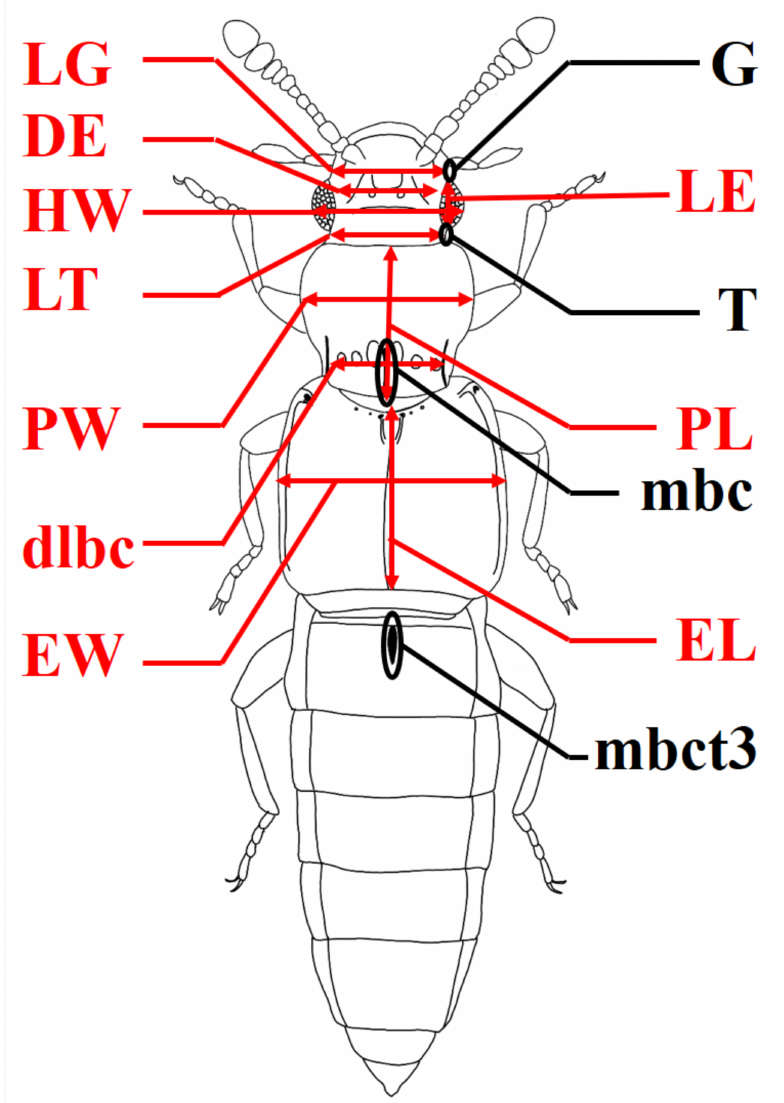
Figure 1. Abbreviation of morphological character: DE–distance between eyes; dlbc–distance of the latero-basal carinae of the pronotum; EL–greatest length of elytra; EW–greatest width of ely- tra; G–gena; HW–width of head; LE–length of eyes; LG–length of genae; LT–length of temples; mbc–medio-basal carina of the pronotum; mbct3–medio-basal carina of tergite III; PL–length of pronotum; PW–width of pronotum;